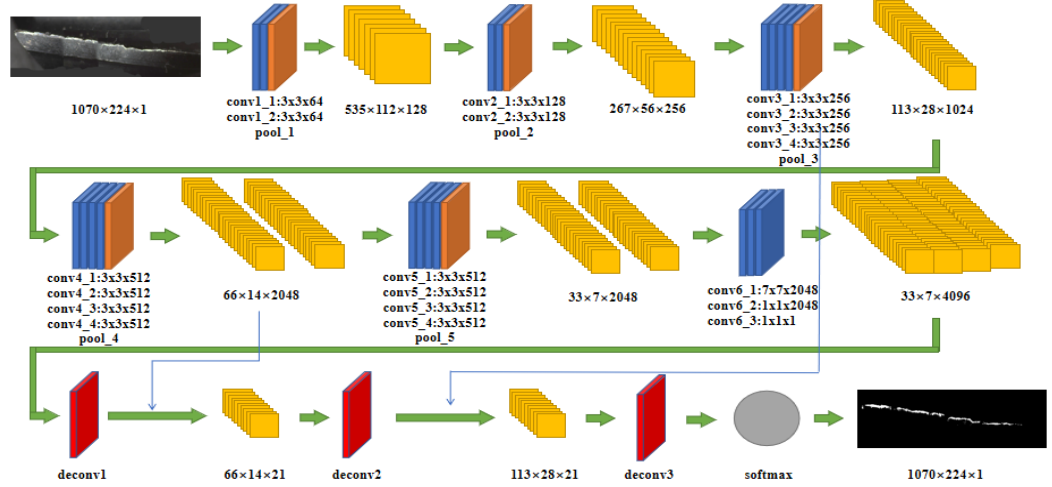
Figure 7. FCN model for holographic image segmentation of end mill side edge.